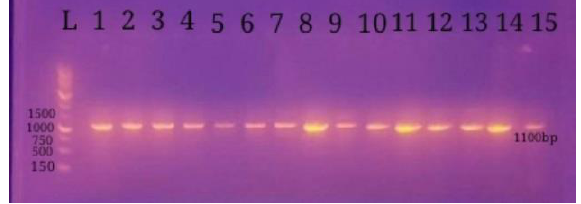
Figure, 3: Agarose gel (1.5 %) electrophoresis of amplified DNA from Theileria spp. lane M: 1